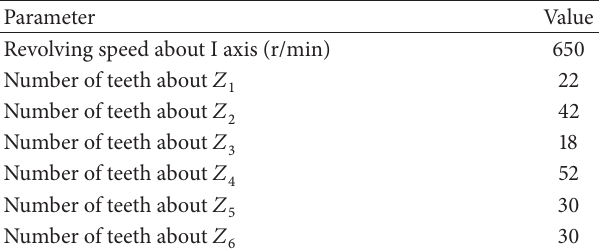
Table 3: The main parameters of transmission